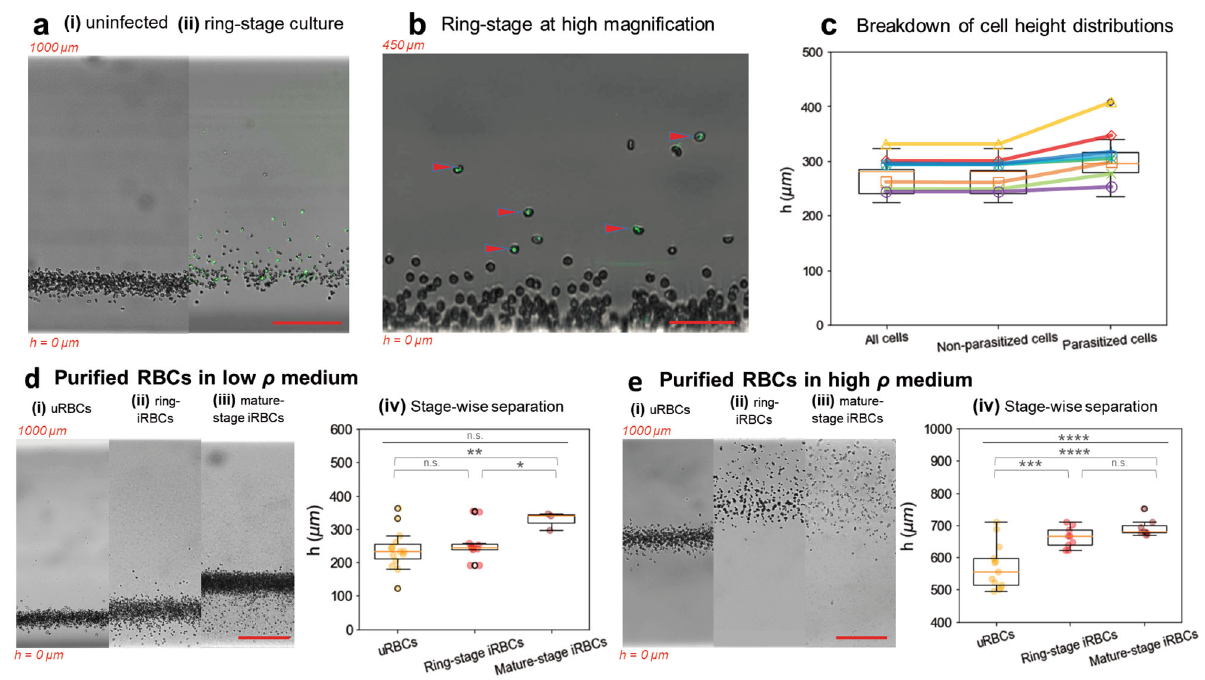
Fig. 3 Levitation of P. falciparum-infected human erythrocytes from 3D7 cultures. h refers to levitation height ( µ m), Χ refers to magnetic susceptibility (unitless), and ρ refers to density (g/mL). RBC refers to red blood cells, or erythrocytes, uRBC to uninfected RBCs, ring-iRBC to ring-stage synchronized infected RBCs, and troph-iRBC to trophozoite-stage infected RBCs. a Levitation images of (i) uninfected RBCs and (ii) infected culture containing 5% parasitized RBCs in bright- fi eld merged with fl uorescence (acridine orange staining marking parasites by nucleic acid content, in green). Scale bar = 200 µ m. b Magni fi ed image of infected culture in levitation with PicoGreen stained parasites (red arrows). Scale bar = 100 µ m. c Fluorescence-based quanti fi cation of parasitized components of ring-stage synchronized infected cultures. The mean height of parasitized RBCs (determined by fl uorescent labeling with acridine orange), 304 µ m, is distinct from that of non-parasitized RBCs (bright fi eld-only cells without fl uorescent signal) 269 µ m. Each of the eight series of identically colored circles represents subsets of the same, biologically independent, sample. d Levitation images of (i) uninfected RBCs, (ii) ring-stage parasitized RBCs (puri fi ed with streptolysin O; SLO), and (iii) mature-stage (trophozoite to schizont) parasitized RBCs (puri fi ed with streptolysin O; SLO) in low- Χ , low- ρ medium. Scale bar = 200 µ m. (iv) Stage-speci fi c measurements of levitation height comparing uninfected RBC samples ( n = 14, yellow circles) and SLO-puri fi ed parasitized RBC samples from ring-stage synchronized cultures ( n = 11, orange circles) or SLO-puri fi ed mature-stage cultures ( n = 3, brown circles) in low- Χ , low- ρ medium. Mature-stage cells levitate higher than uninfected RBCs ( p = 0.0050), and ring-stage cells ( p = 0.016). Other differences were not found to be signi fi cant. e Levitation images of (i) uninfected RBCs, (ii) ring-stage parasitized RBCs (SLO-puri fi ed), and (iii) mature-stage parasitized RBCs (SLO-puri fi ed) in low- Χ , high- ρ medium. Scale bar = 200 µ m. (iv) Stage-speci fi c measurements of levitation height comparing uninfected RBC samples ( n = 13, yellow circles) and SLO-puri fi ed parasitized RBC samples from ring-stage synchronized cultures ( n = 8, orange circles) or mature-stage cultures ( n = 9, brown circles) in low- Χ , high- ρ medium. Ring-stage infected RBCs levitate higher than uninfected RBCs ( p = 0.00074), and mature-stage RBCs levitate higher than uninfected RBCs ( p = 0.000038). For both d (iii) and e (iii), ANOVA was used to compare across groups (asterisks indicate statistical signi fi cance across groups). Welch ’ s t -test was also used to compare between groups. * p < 0.05; ** p < 0.01; *** p < 0.001; **** p < 0.0001. Box plots represent upper and lower quartiles, with the center line marking the median, and the whiskers showing the range of the data. All samples shown are biologically independent unless otherwise